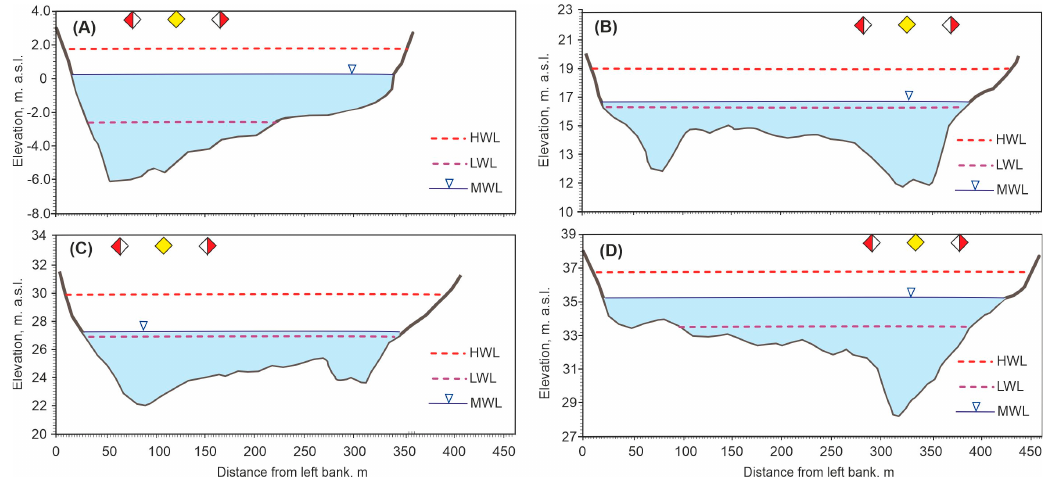
Figure 5. Vistula River depths on the selected cross sections over the bridge axis with HWL and LWL limits appointed B1 ( A ), B6 ( B ), B9 ( C ), and B10 ( D ). Table 6. Results of UKC probabilistic model for the analysed bridges’ cross-sections on Vistula’s